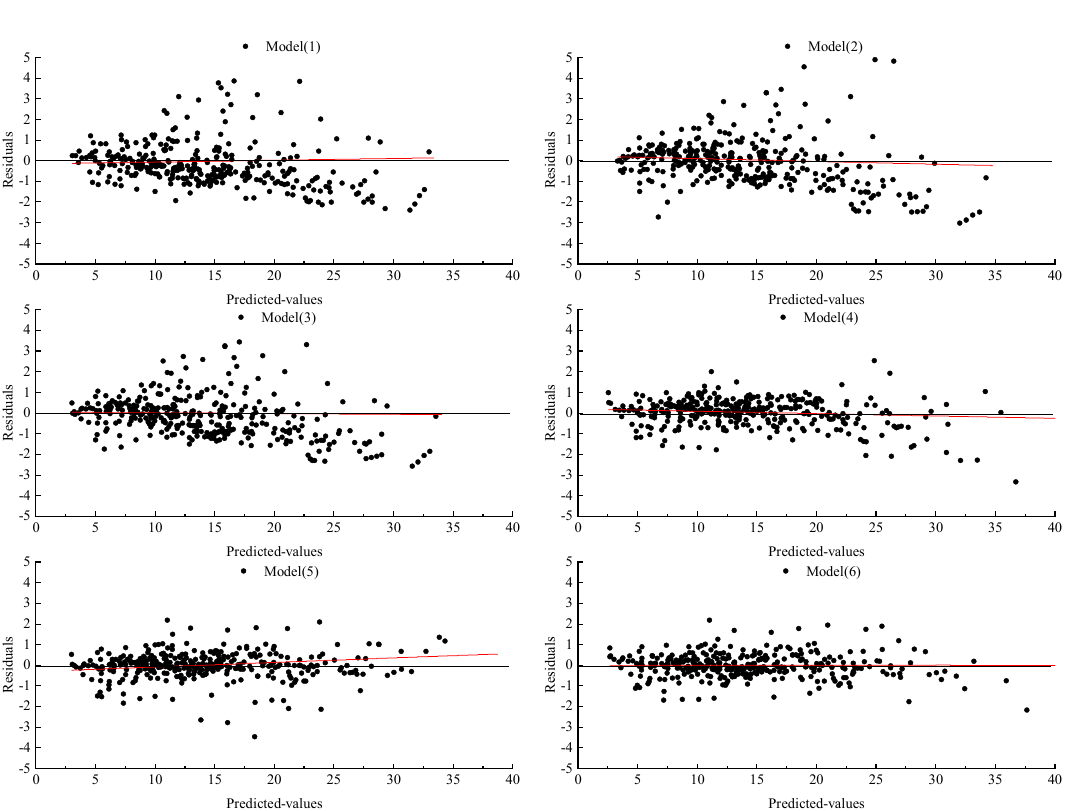
Figure 3. Model residual distribution of the TLS data.